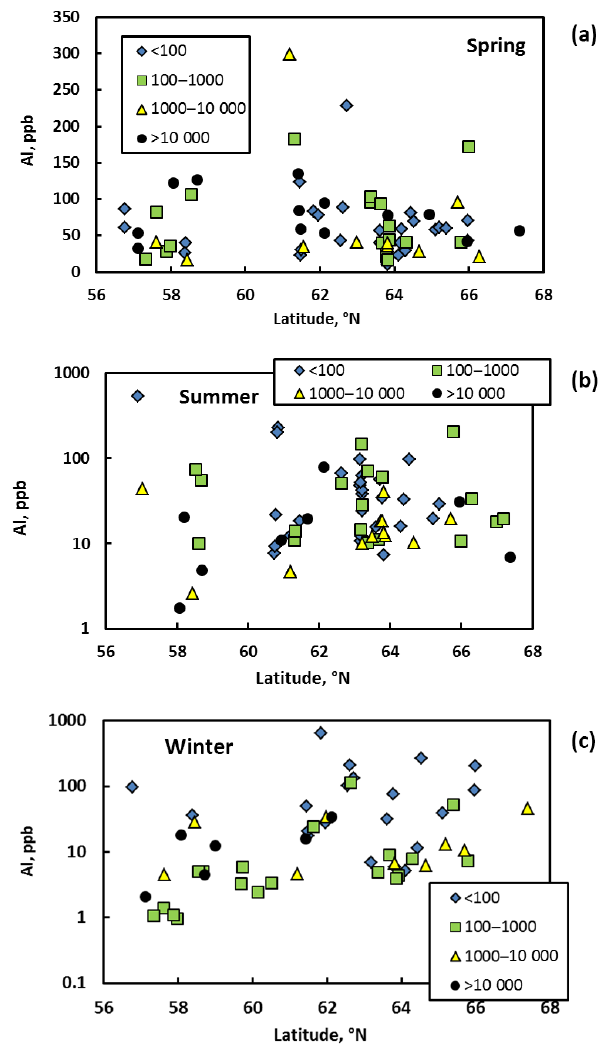
Figure 4. Variation in Mn concentration with latitude during spring (a) , summer (b) and winter (c) for watershed of different size. The symbols are the same as in Fig. 2. Note the factor of 10 higher Mn concentrations in winter compared to spring and summer, pre- sumably linked to Mn reduction in anoxic waters. The latitudinal trends and the differences between different watershed sizes are not statistically significant ( p